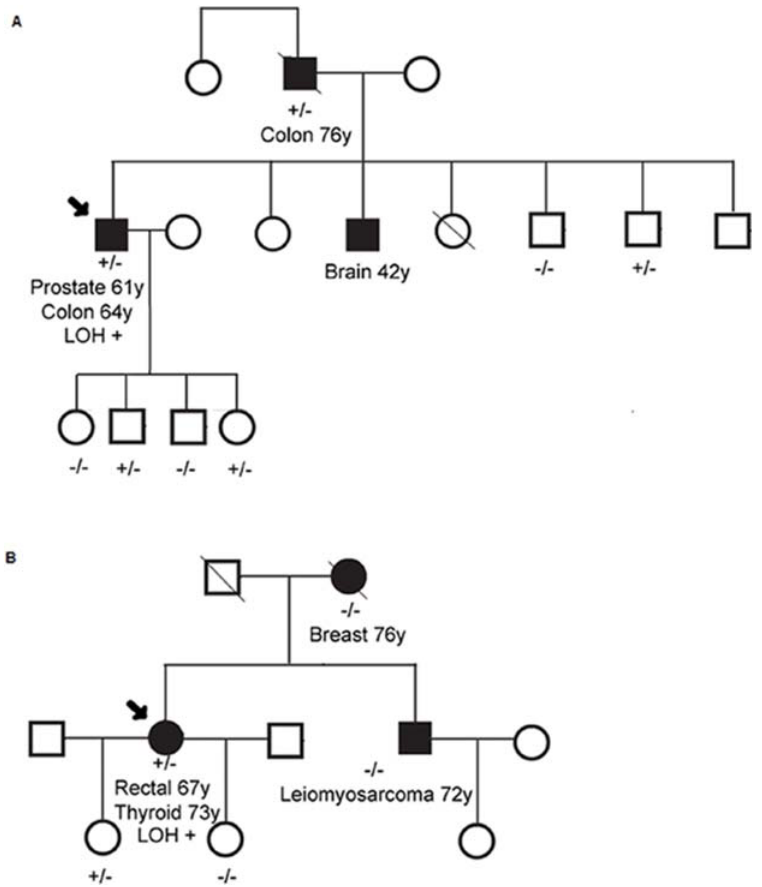
Figure 1. Pedigrees of colorectal cancer cases carrying the A438T (Family 1, Panel A) and G787R (Family 1, Panel B) variants. + / 2 , carrier; 2 / 2 , non-carrier; LOH + , Colorectal tumour tissue was found to manifest LOH, with loss of the wild-type allele; Ca,